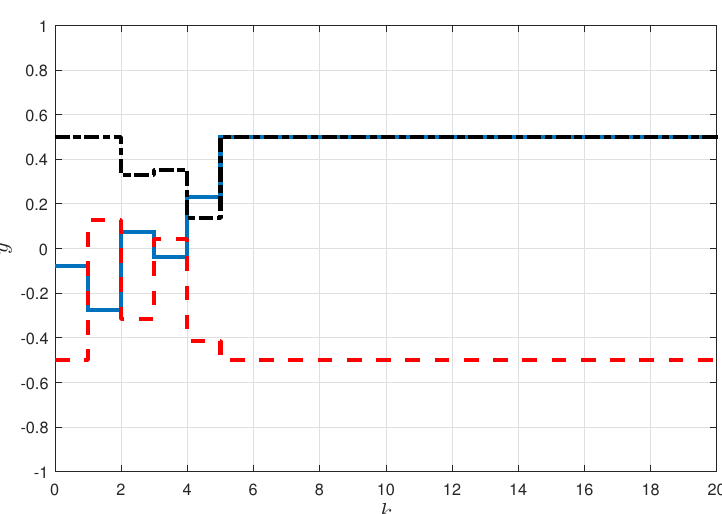
Figure 6. Response of the ratio γ ( k ) .